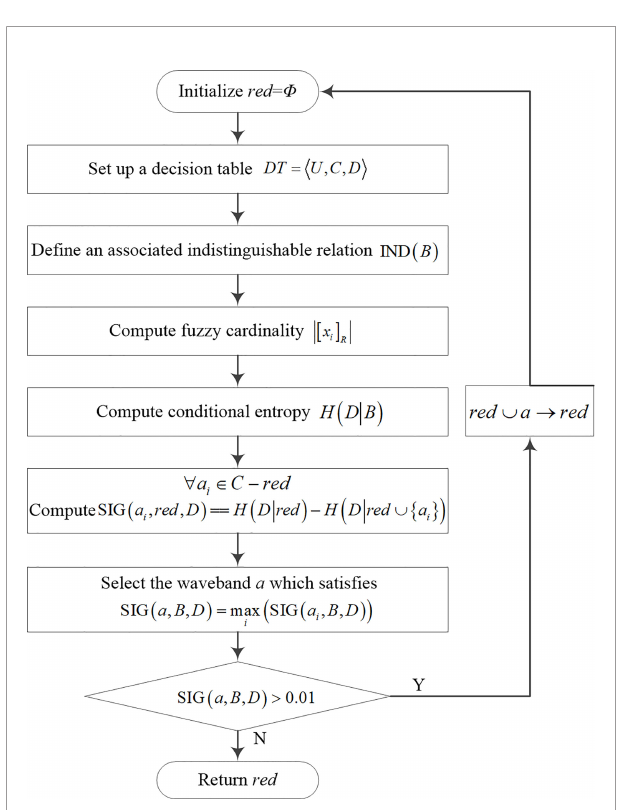
FIGURE 2 | The fl ow chart of the waveband selection algorithm based on the FRS